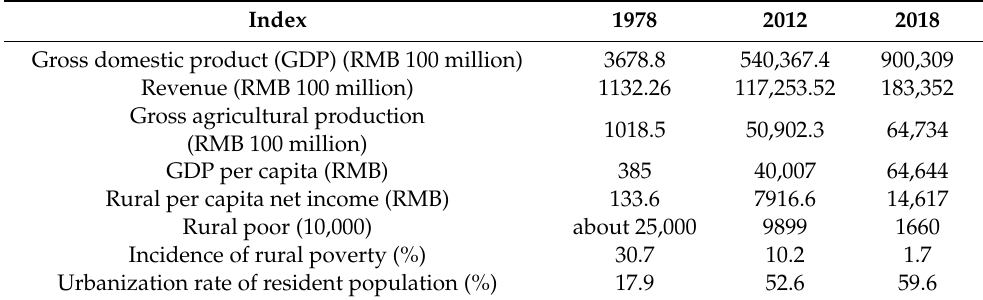
Table 2. Material basis of rural revitalization since the reform and